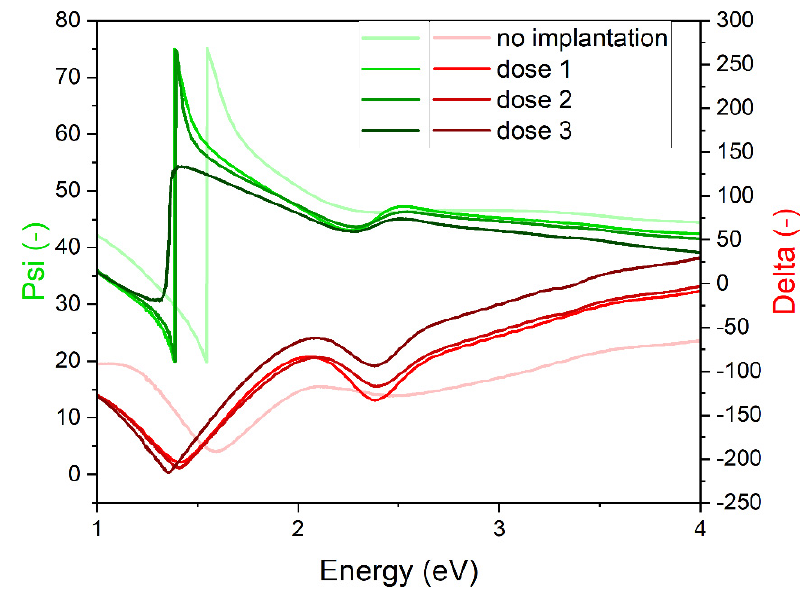
Figure 4. Psi and Delta measured for representative points of all Cu 2 O samples deposited on Si.